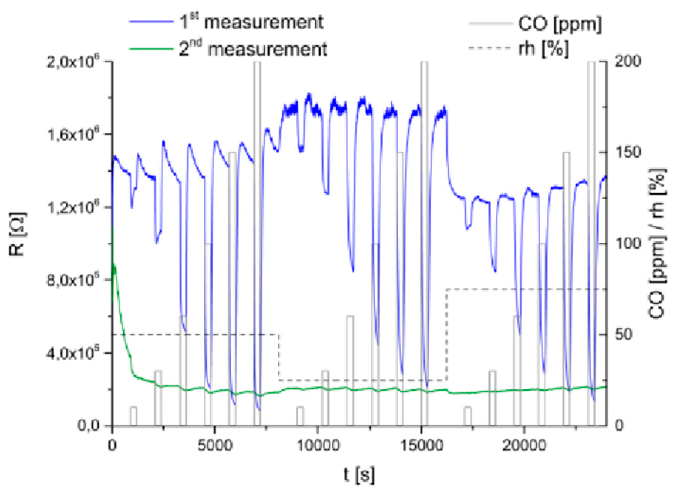
Figure 2. Response of SnO 2 thin film sensor, functionalized with NiPt-NPs towards